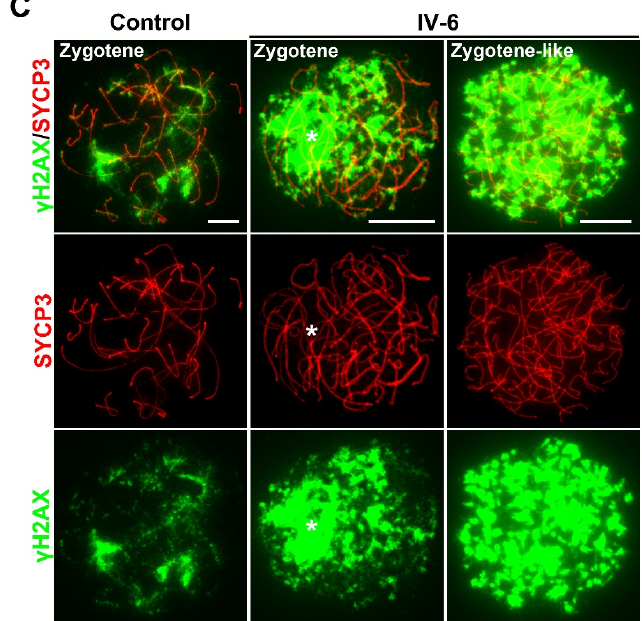
Figure 5. The failure of homolog synapsis and DSBs repair in the spermatocytes of patient. ( A ) Repre- sentative images of the surface-spread spermatocytes from the control and patient IV-6 stained with antibodies against SYCP3 (red) and SIX6OS1 (green). Scale bars, 10 µ m. ( B ) Composition of the sper- matocytes from control and IV-6. n, the number of spermatocytes analyzed. ( C ) Immunofluorescence staining of surface-spread spermatocytes from the control and IV-6 with antibodies against SYCP3 (red) and γ H2AX (green). Asterisk indicates intensive γ H2AX signal on the unsynapsed region. Scale bars, 10 µ